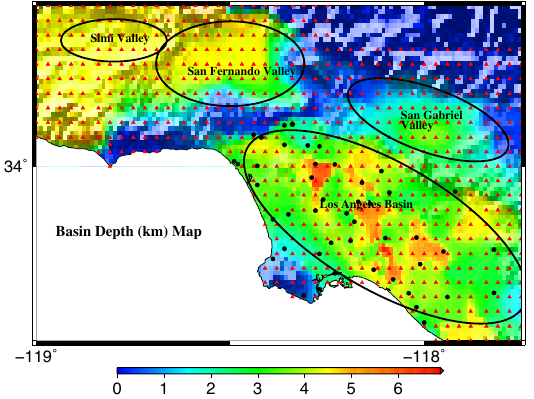
Figure 7. Basin depth (km) map for southern California. Red triangles indicate the geographical distribution of the 636 southern California sites where ground motions from the scenario earthquakes are computed. The ellipses identify the basins in southern California: Simi valley, San Fernando valley, San Gabriel valley and Los Angeles